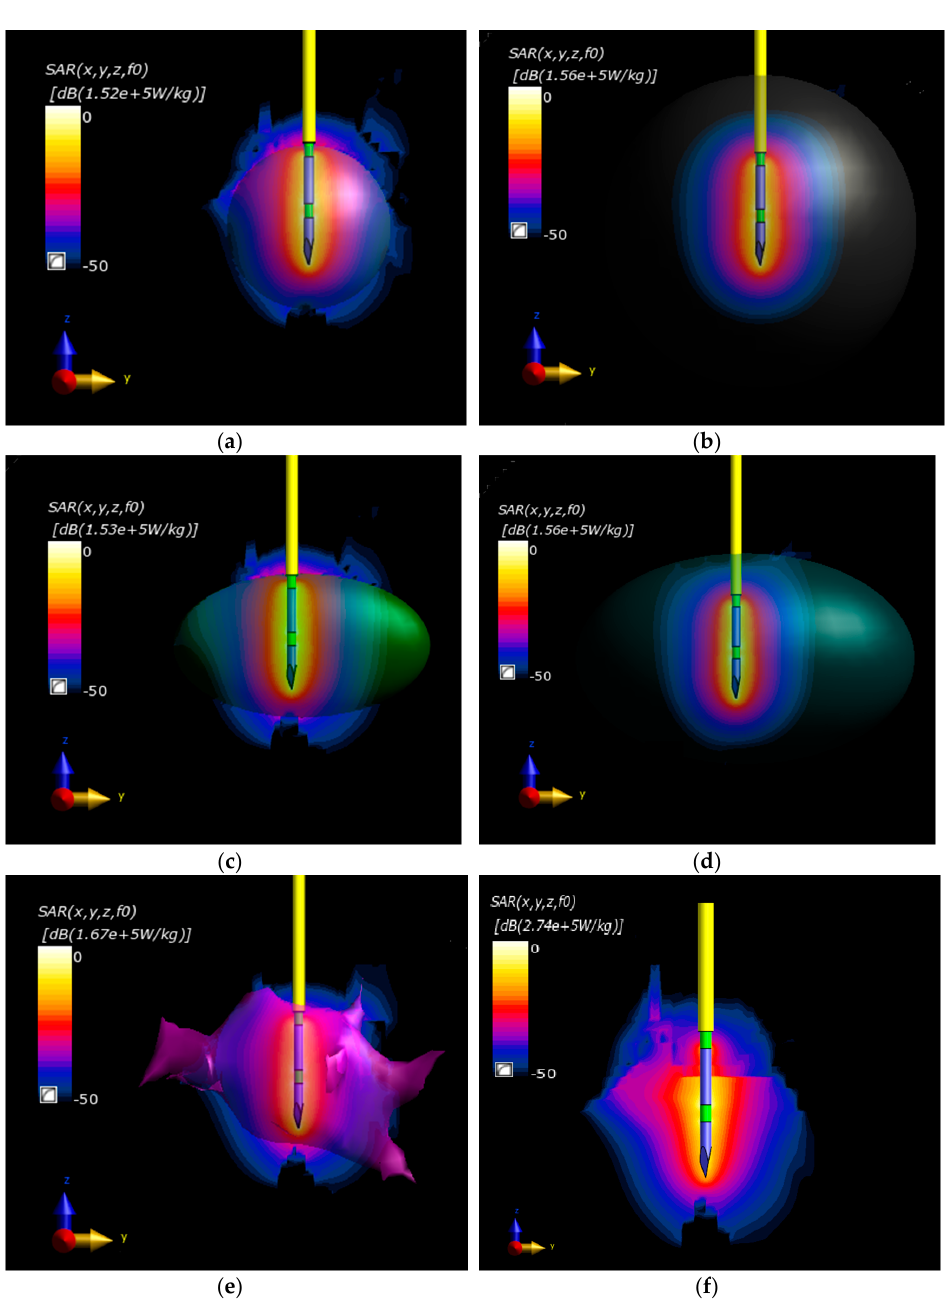
Figure 6. Normalized SAR distributions in the yz plane derived from the RF needle applicator for all analyzed equivalent tumor models: ( a ) sphere S 1 ; ( b ) sphere S 2 ; ( c ) ellipsoid E 1 ; ( d ) ellipsoid E 2 ; ( e ) irregular tumor; ( f ) case without tumor.